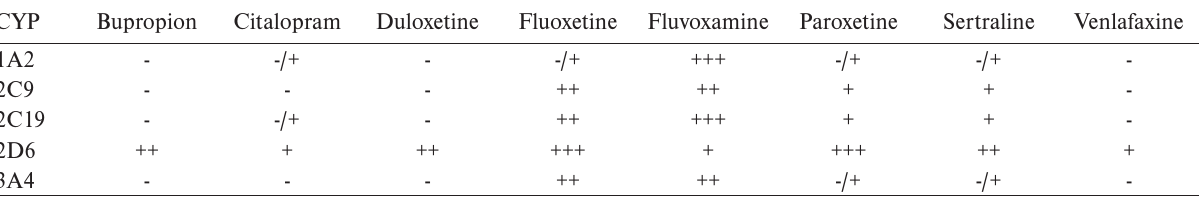
Table 3. Effect of the newer antidepressant drugs in inhibiting the activity of various cytochrome P450 (CYP) forms 18, 52 . CYP